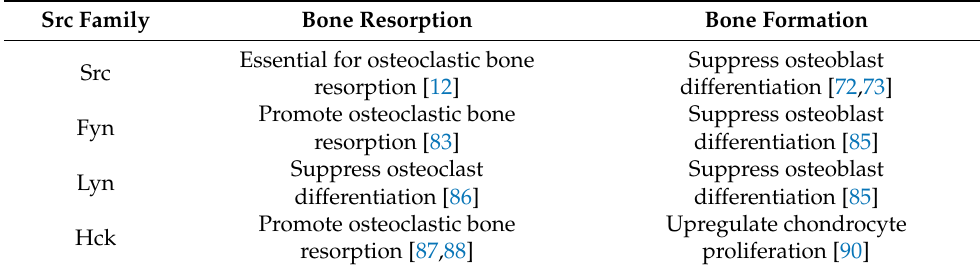
Table 1. The function of Src family kinases in bone resorption and formation. Src Family Bone Resorption Bone Formation Essential for osteoclastic Src